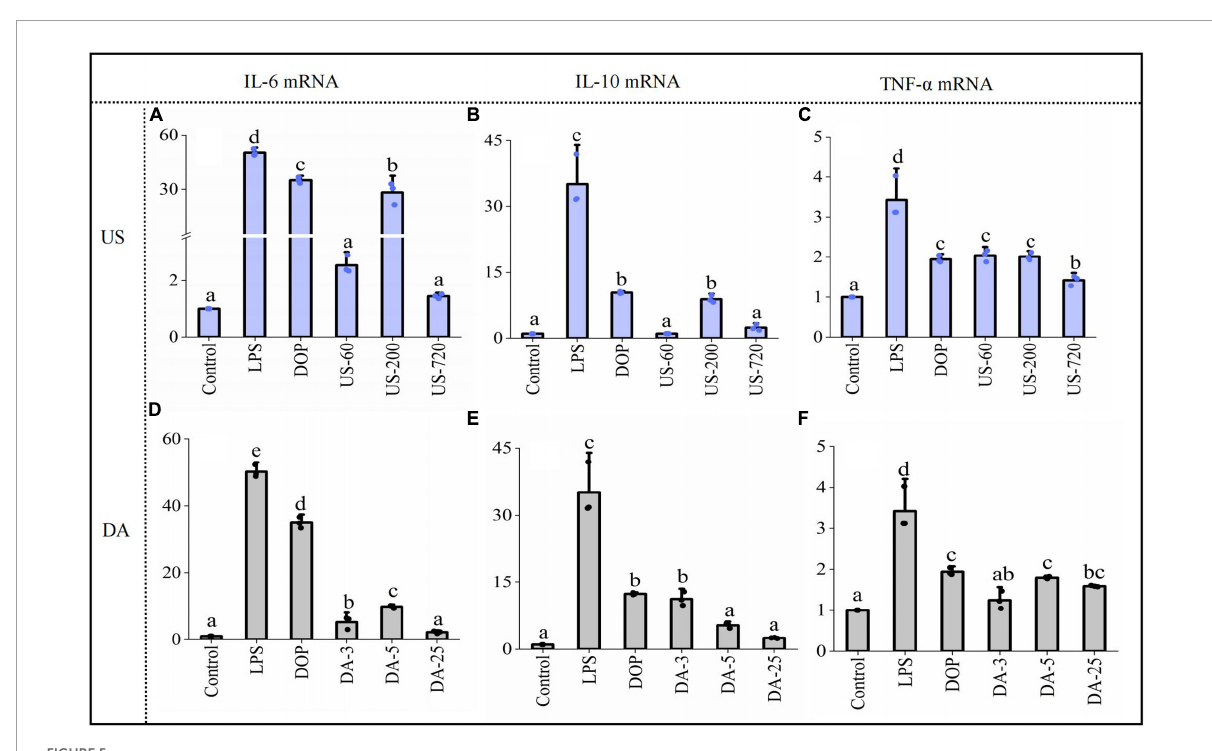
FIGURE5 Polysaccharides induced gene expression of cytokine IL-6 (A,D) , IL-10 (B,E) , TNF- α (C,F) productions (24 h) by macrophages RAW264.7 exposed to ultrasonic and de-acetylated samples (100 µ g/ml) were assessed by RT-qPCR. Data are expressed as means plus SD of triplicate culture (different letters indicated significant differences at p <